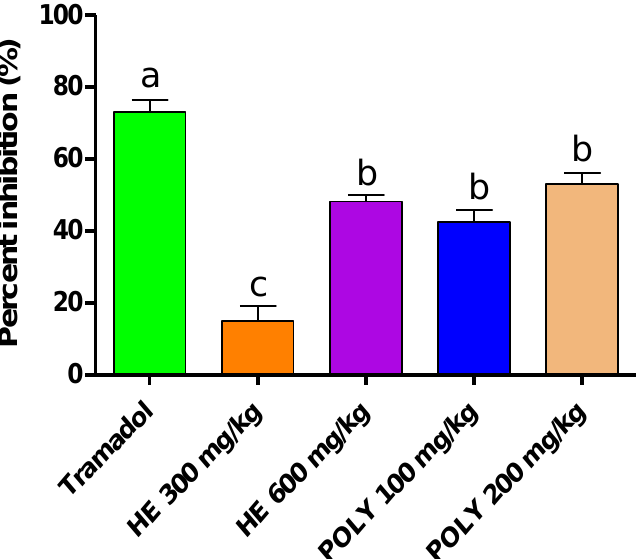
Figure 3. The inhibitory influence of L. officinalis Chaix. extracts on contortions in mice. The different letters in superscript (a,b,c) represent the treatment differences that are statistically significant at p < 0.05. Tramadol: reference analgesic drug.